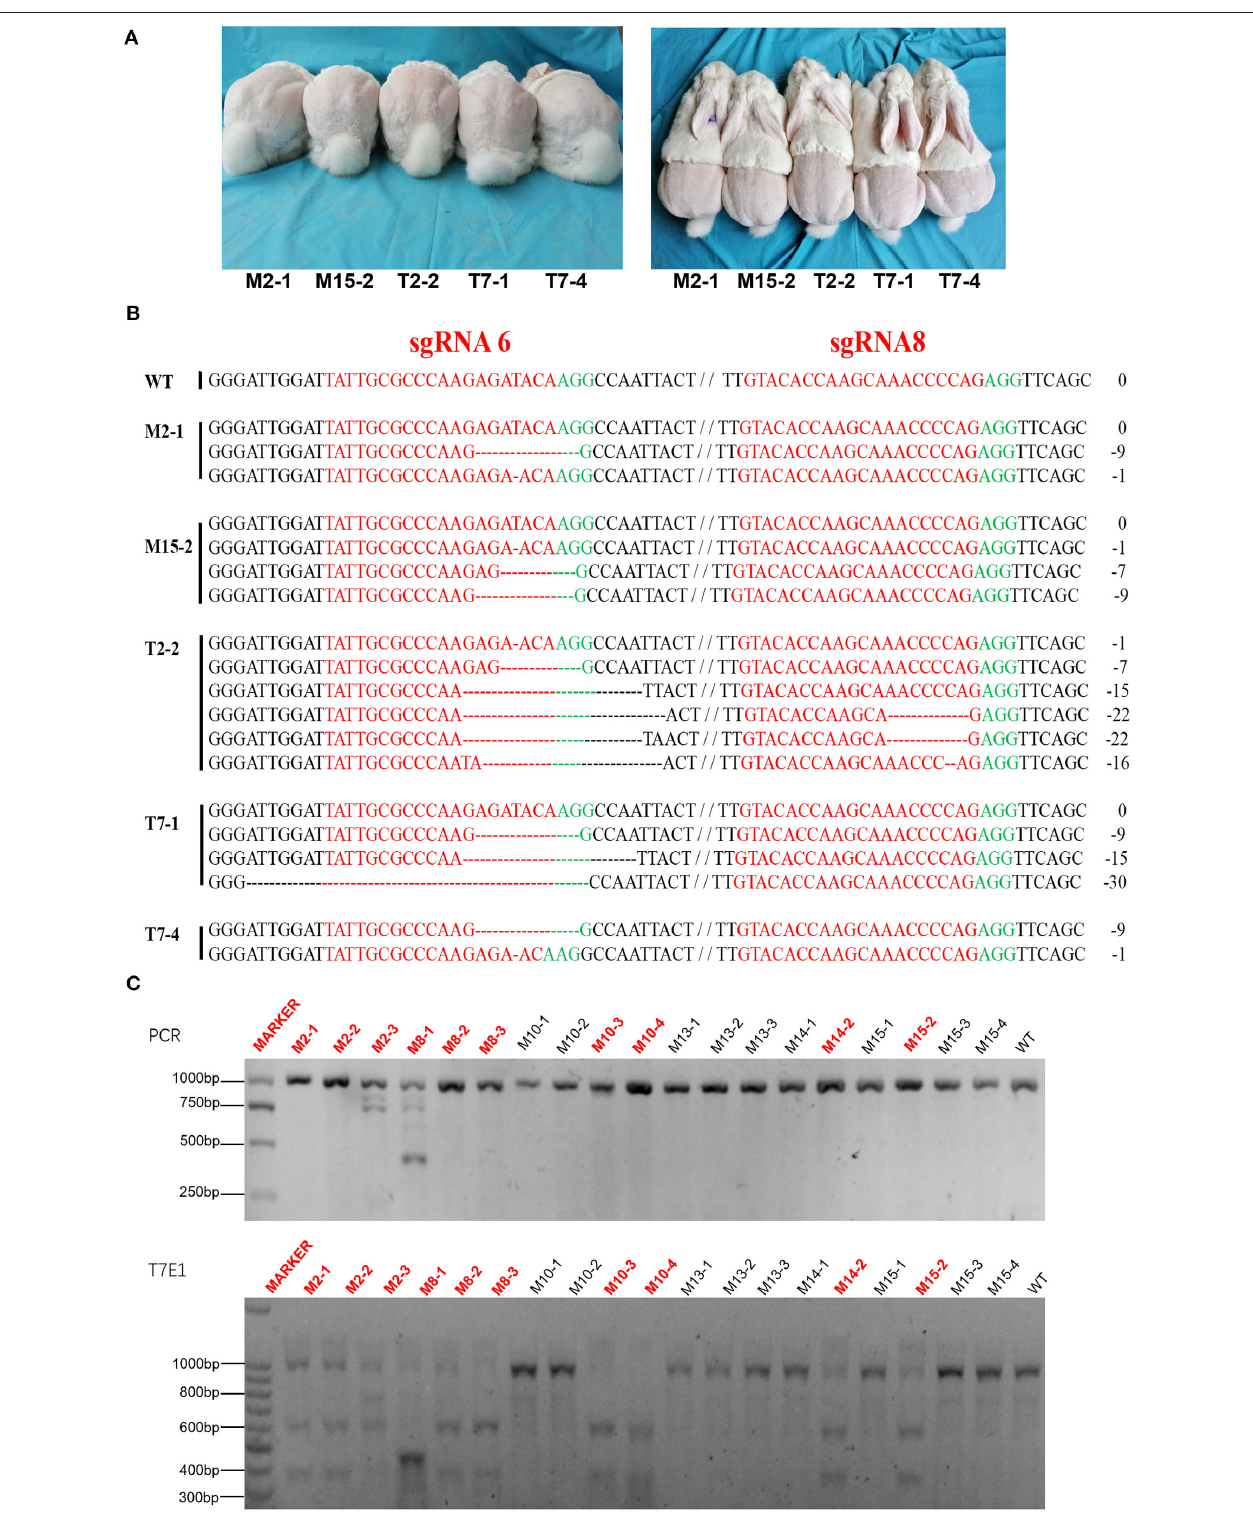
FIGURE 4 | Generation of F0 MSTN KO rabbits via CRISPR/Cas9. (A) Five mutated rabbits of F0. (B) Sanger sequence analysis of mutated rabbits. Five rabbits edited were named on the left. WT stands for wild type control; PAM sequence is marked in green. The sgRNAs sequence is marked in red. The numbers on the right indicated the type of mutation, with “-” represents deletion of the given number of nucleotides. (C) Upper: The results of sequencing for mutations at the specific sites in Agarose gel electrophoresis of PCR products about a part of pups of F0. Lower: T7E1 cleavage assay for the rabbits (The picture has been cropped).